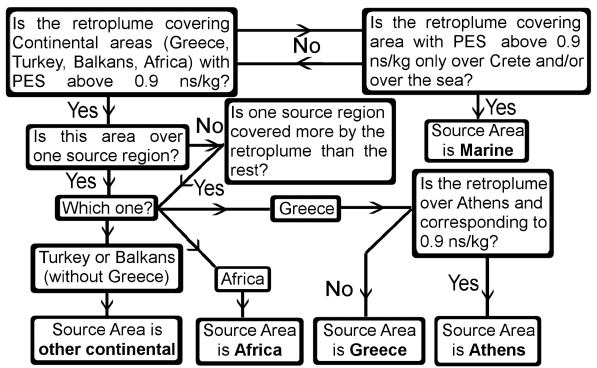
Fig. 2. Source region analysis: flowchart of the decision